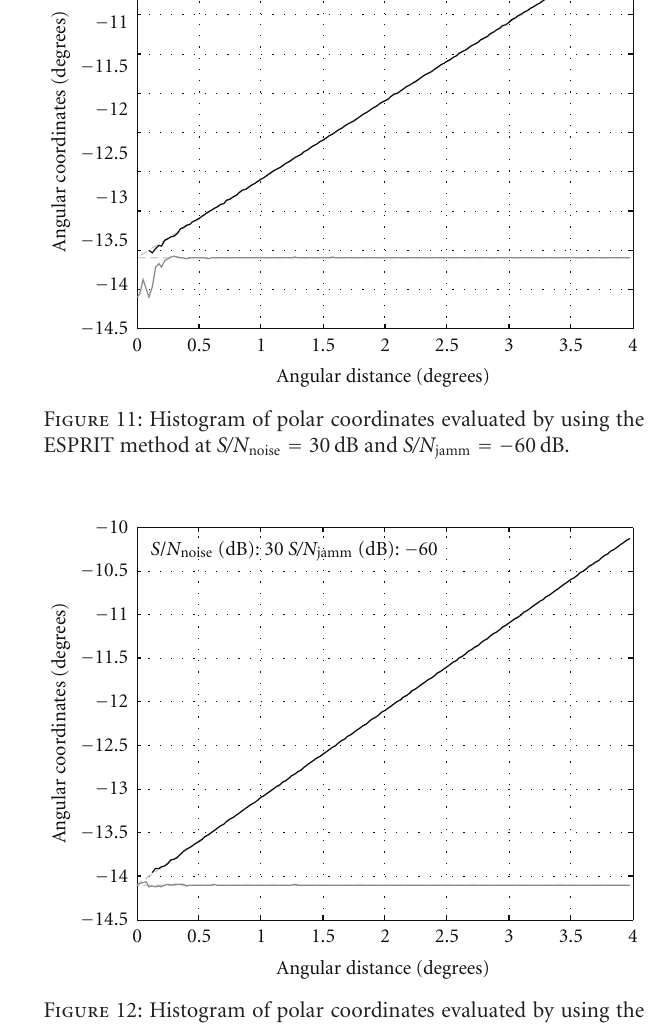
Figure 10: Histogram of polar coordinates evaluated by using the TLS ESPRIT method at S/N noise = 6dB and S/N jamm = − 60dB.